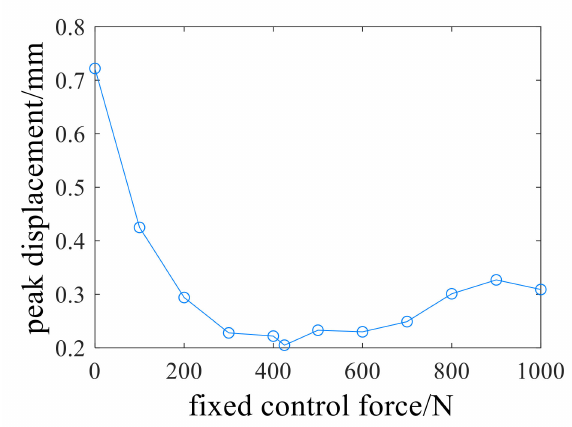
Figure 8. Relationship between peak value of over-critical response of shafting and fixed control force.